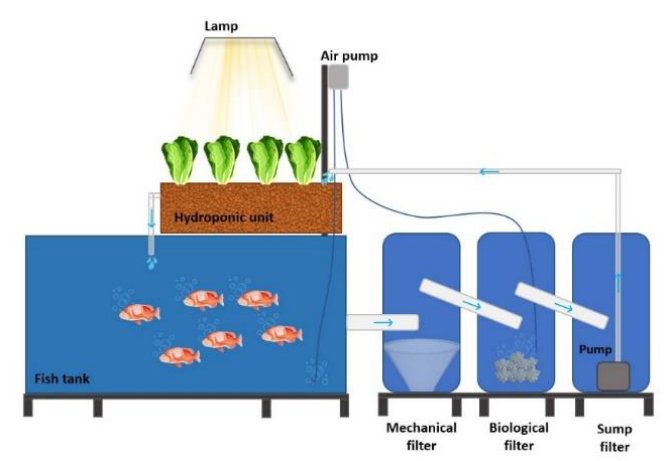
Figure 1. Schematic side view of one lab-scale aquaponic system used in the experiment. The arrows indicate the water flow inside the system.